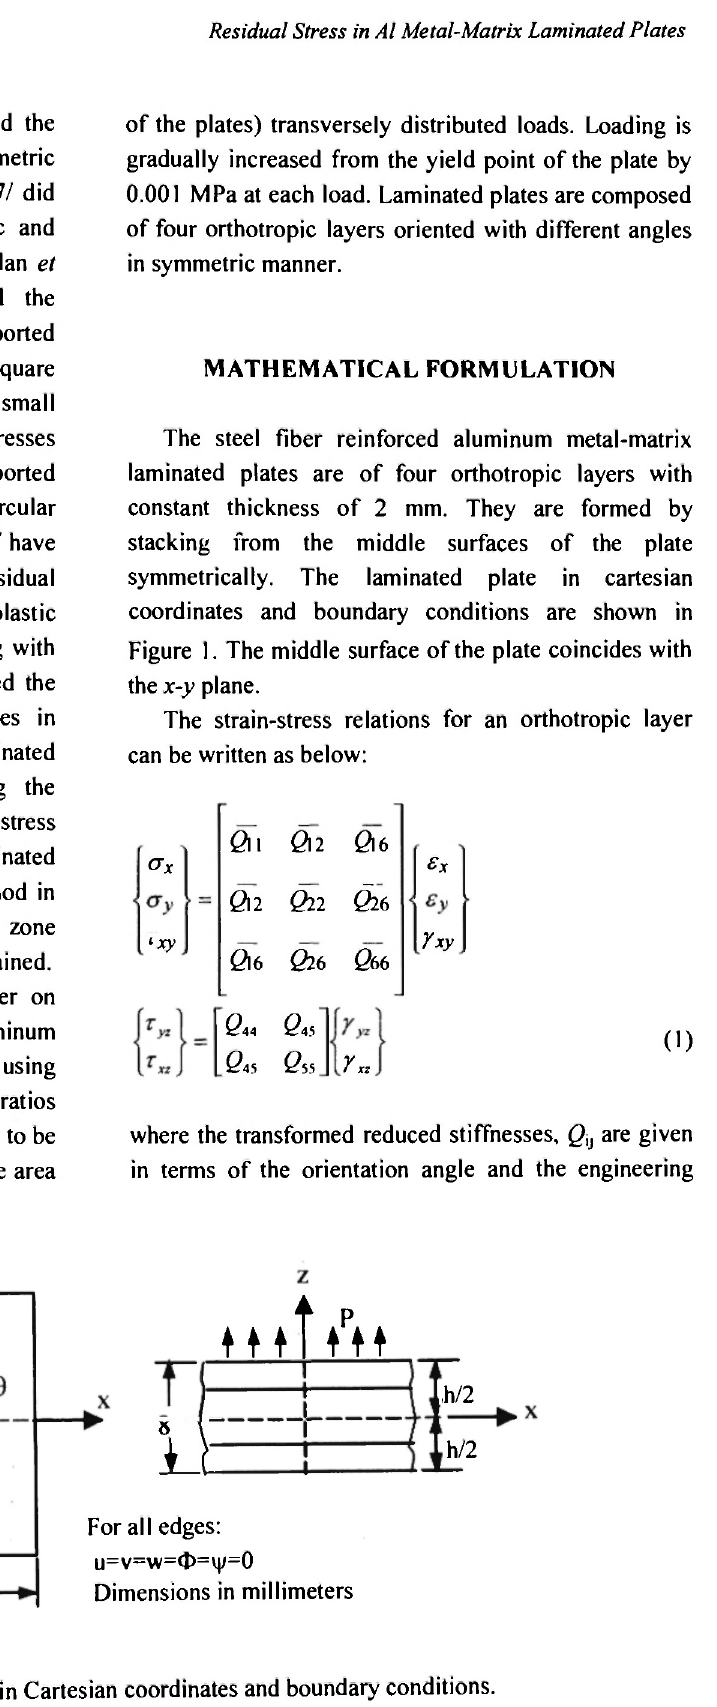
Fig. 1: Geometry of the plate in Cartesian coordinates and boundary